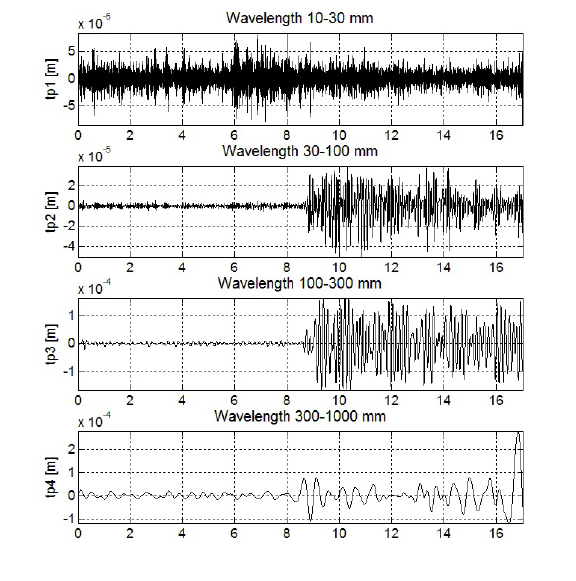
Figure 4. The processed record from the device Salamander shows a track, where in one part the rails were replaced and in the other part the rails with long-pitch corrugation were left.